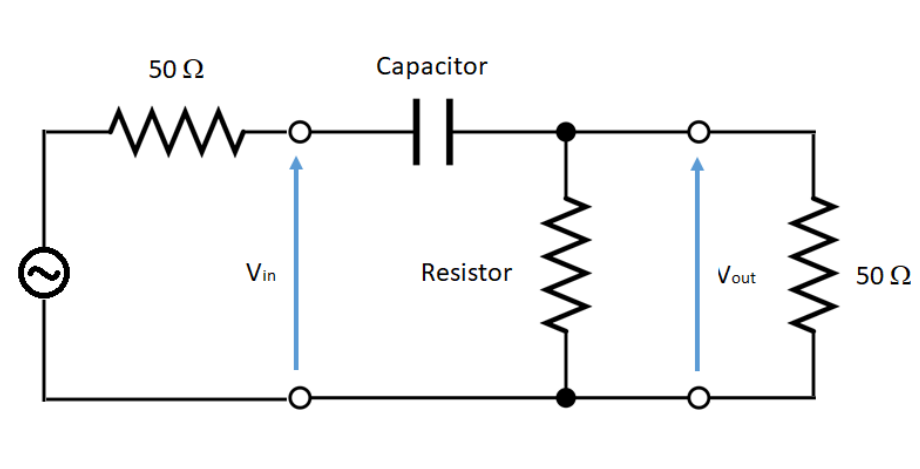
Figure 10. First-order high-pass filter model: this type of filter is a series combination of a capacitor and a